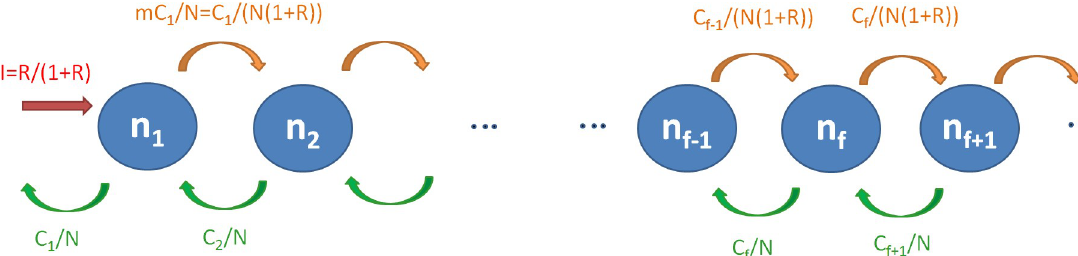
Fig 4. Occupancy class model schematic. Singletons (clones of size 1) are produced by infectious spread (red). Proliferation (orange) results in loss from clone size class n f and entry into size class n f + 1 . Death of a cell (green) results in a clone moving from size class f to size class n f— 1